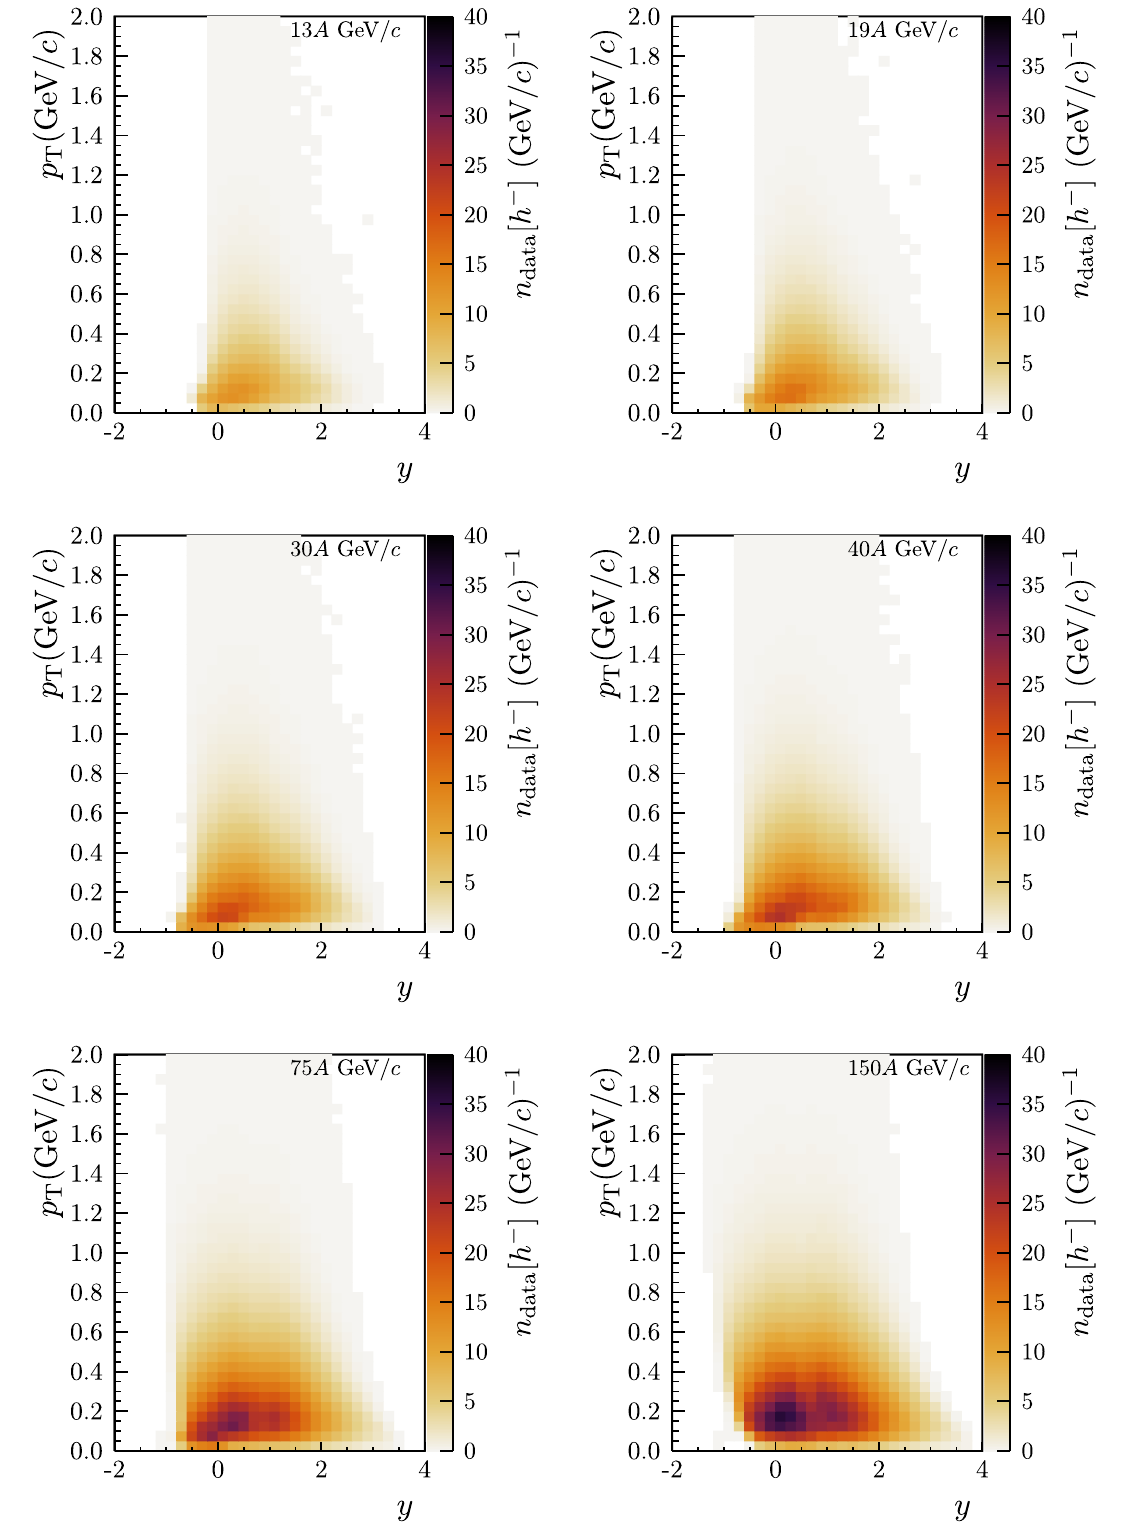
Fig. 7 Uncorrected double-differential spectra n [ h − ] raw /(cid:5) y /(cid:5) p T of negatively charged hadrons produced in the 5% Ar+Sc collisions with the smallest E PSD energy at beam momenta of 13 A , 19 A , 30 A , 40 A , 75 A and 150 A GeV /